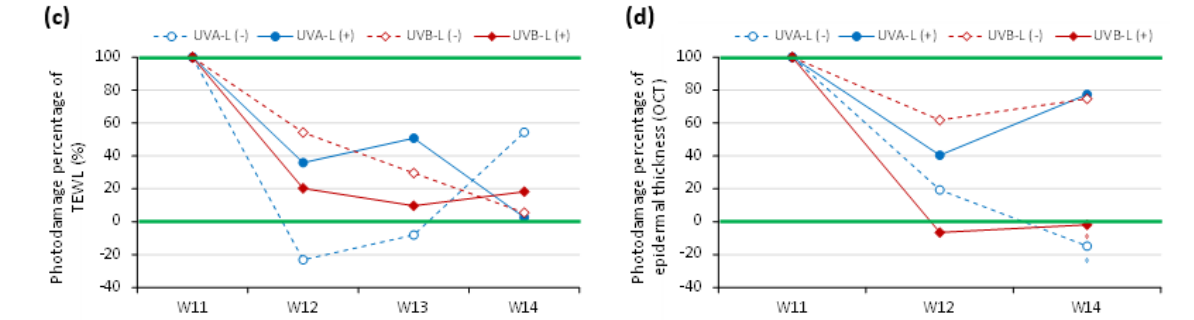
Figure 5. Photodamage percentile curve in UVA-/UVB-irradiated groups with spontaneous reversal (dotted lines) and laser-assisted reversal (solid lines). ( a ) collagen intensity, ( b ) erythema, ( c ) TEWL, and ( d ) epidermal thickening measured by OCT.